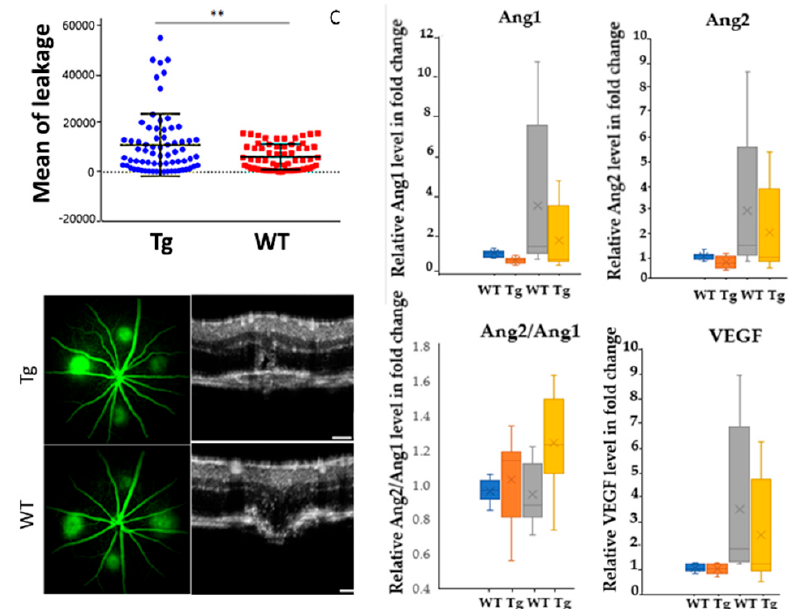
Figure 8. Leakage and change of angiogenic factors expression in laser-induced CNV mice. ( A ) Dye leakage from the CNV lesion in CAG-HtrA1 Tg mice and wild-type control (10 weeks) after one-week observation post laser treatment. Mean leakage is calculated between the CAG-HtrA1 Tg mice and wild-type control. ( B ) Representative FFA image and the corresponding lesions of the OCT. ( C ) Multiplex assay. Expression level of cytokine Ang1 is significantly decreased in CAG-HtrA1 Tg compared to WT ( Left ). After laser treatment, Ang1, Ang2, and VEGF were upregulated. The ratio of Ang2/Ang1 was significantly increased in CAG- HtrA1Tg mice after laser treatment. 10 weeks, ( n = 8) for each group (pre- and post-laser). The Mann-Whitney U test was performed. Significance level was defined as ** p < 0.01 and * p < 0.05. (NT: no treatment, WT: wild type, Tg: CAG-HtrA1